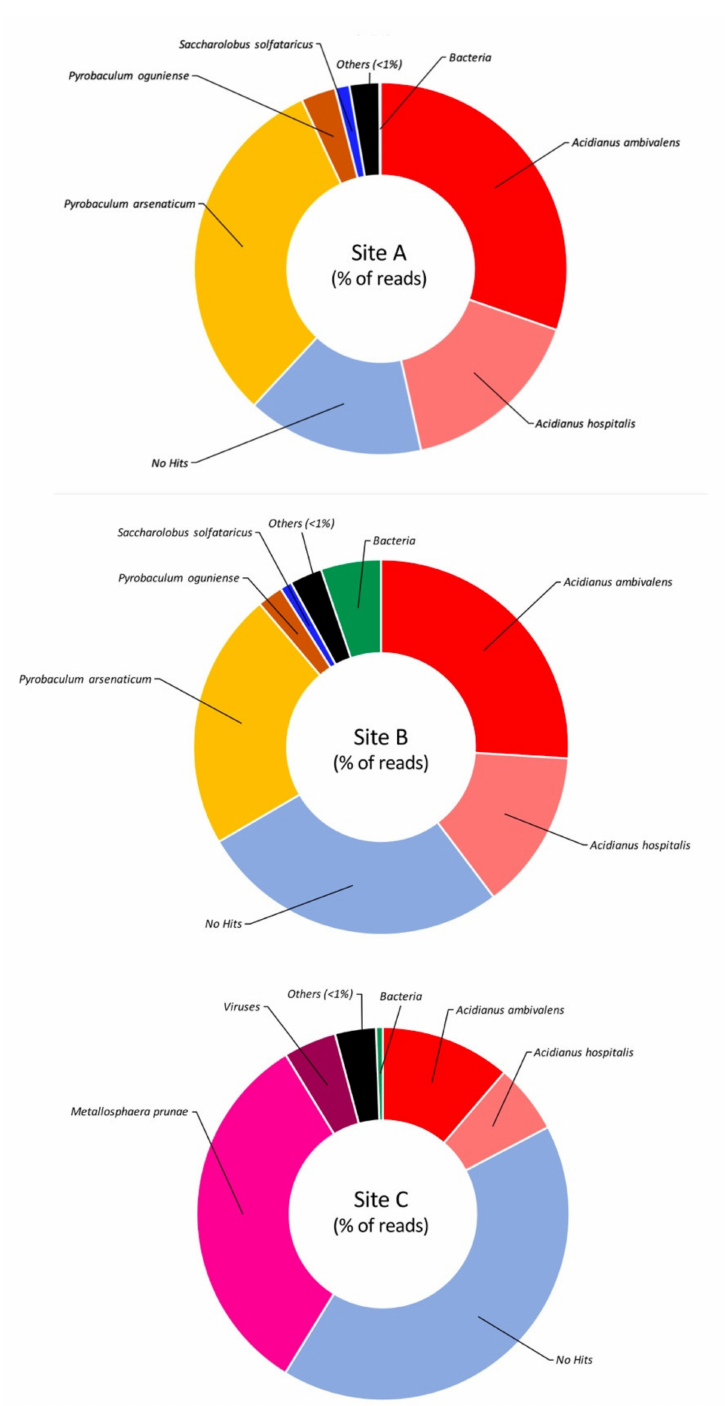
Figure 4. Taxonomic assignment of the reads at the species level. Taxa showing less than 1% of assigned reads are grouped as